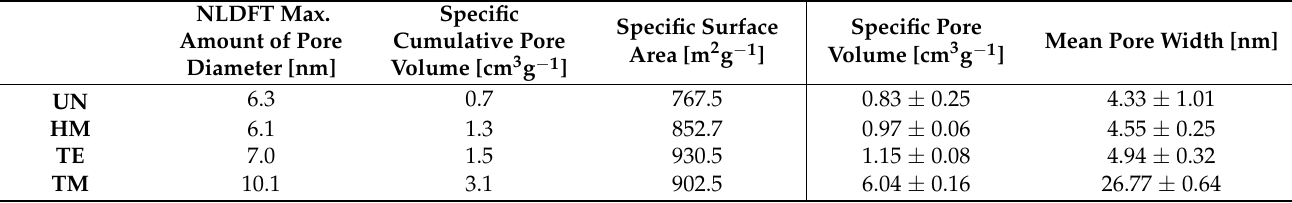
Table 2. Summary of the NLDFT maximum amount of pore diameter, specific cumulative pore volume, and specific surface area determined by nitrogen sorption measurements and NLDFT calculations, as well as the specific pore volume and mean pore width, as estimated from the bulk and skeletal densities for the unmodified UN, hexamethyldisilazane-modified HM, triethylchlorosilane- modified TE, and trimethylchlorosilane-modified TM